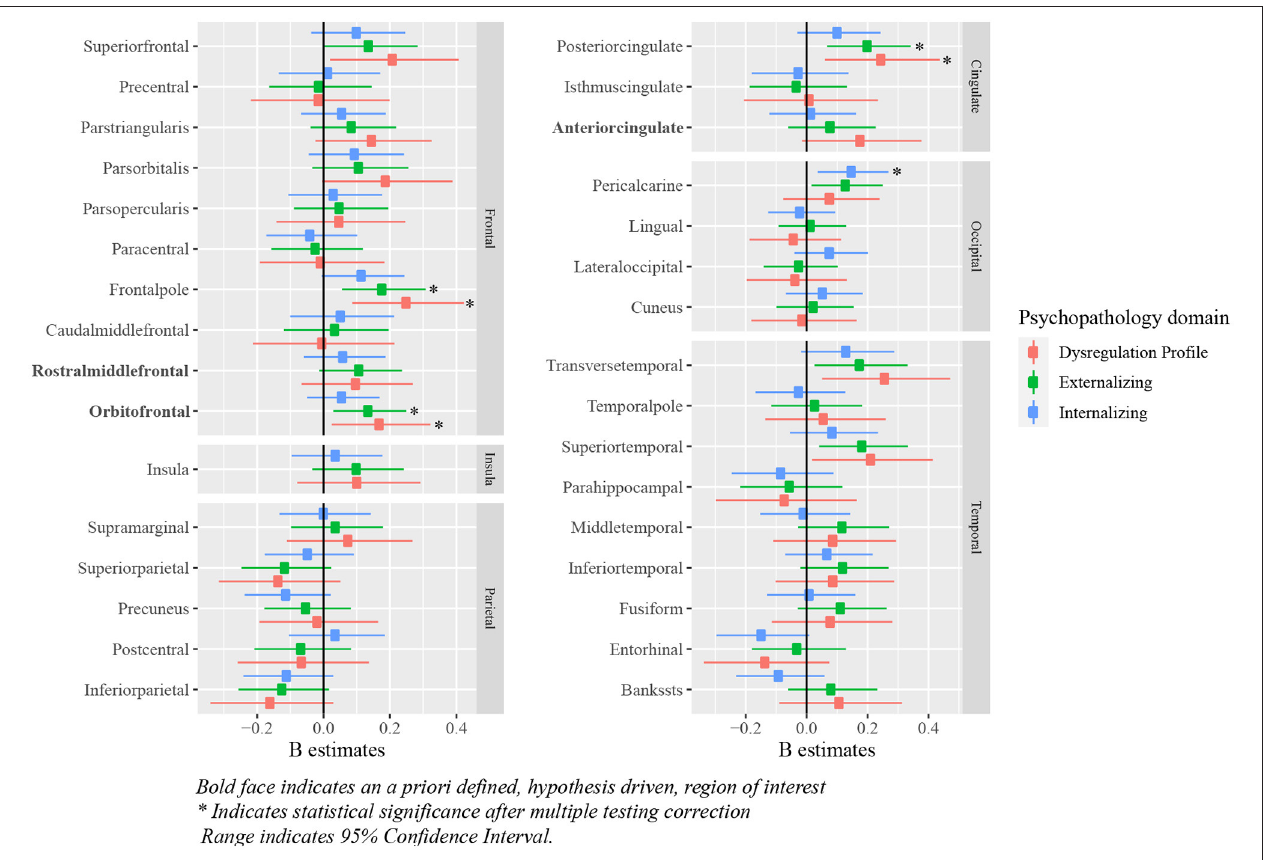
FIGURE 6 | Standardized B estimates of the relationship between z-scores (representing deviations of typical development in cortical thickness) and psychopathology symptoms. Bold face indicates an a priori defined, hypothesis driven, region of interest *indicates statistical significance after multiple testing correction range indicates 95% confidence